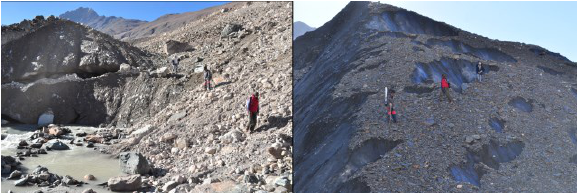
Figure 22. Snout of Smudra Tapu glacier, Chndra basin, H.P. with its end moraine lake and ice wall above snout (Credit: Praveen K. Thakur, glacier field campaign, Oct.